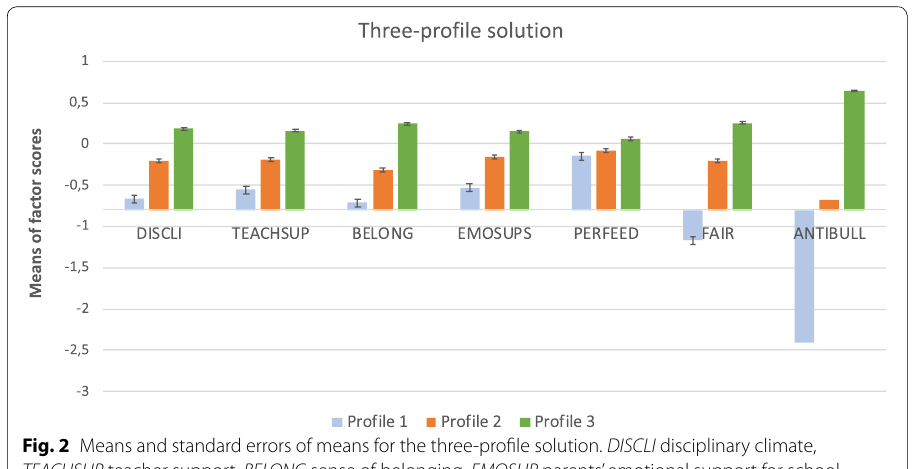
Fig. 2 Means and standard errors of means for the three-profile solution. DISCLI disciplinary climate, TEACHSUP teacher support, BELONG sense of belonging, EMOSUP parents’ emotional support for school, PERFEED perceived feedback from science teachers, FAIR reversed score of ‘unfair teacher’, ANTIBULL reversed score of ‘being